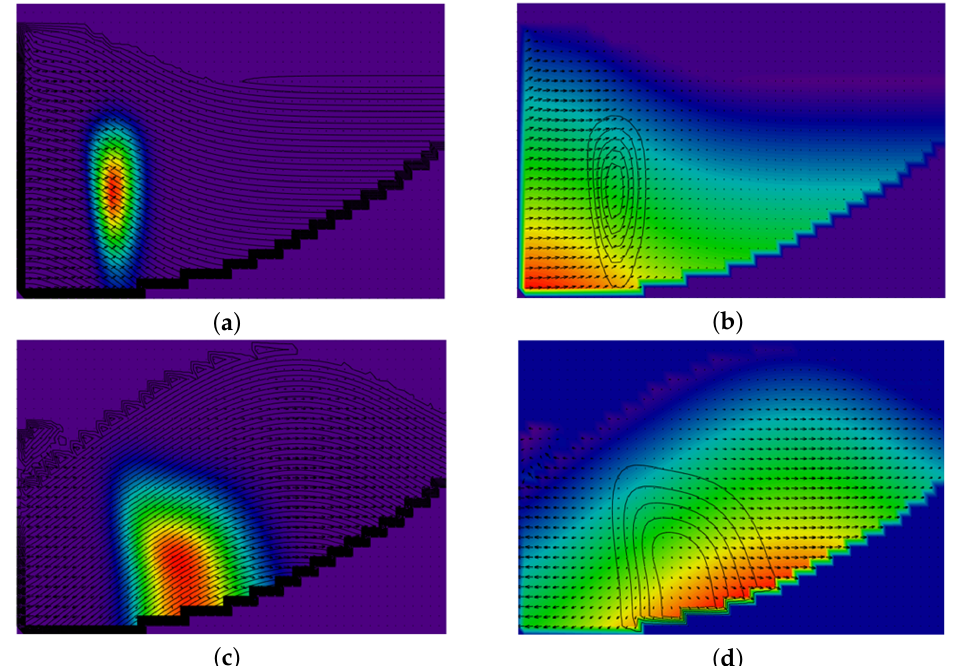
Figure 9. Modeling the release (at the initial moment of time) and spread of suspended particles in the aquatic environment: ( a , c ) suspension concentration after 2 s and 5 s, respectively; ( b , d ) pressure field after 2 s and 5 s,